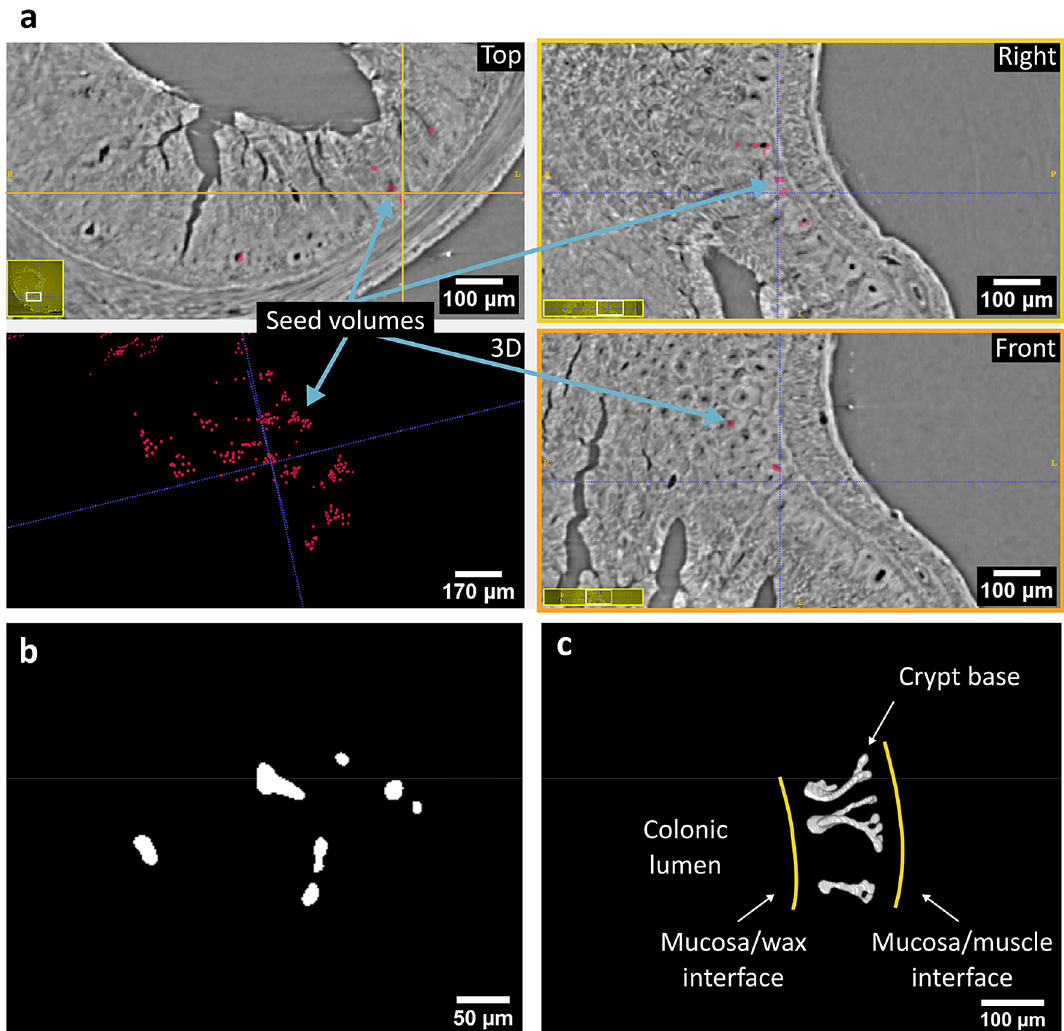
Figure 5. Budding crypt identification and 3D segmentation. ( a ) The viewport of ITK-SNAP is composed of four views (Top, Right, Front and 3D). The panels Top, Right and Front show orthogonal cross sections of the SR CT stack. The panels Right and Front show cross sections across the yellow and orange lines on the panel named Top, respectively. The panel named 3D shows the CT mask with the volumes of the back-mapped seed points (resulting from the inverse mapping between the 3D cyclorama and the CT data). The 3D seed volumes shown in the panel 3D, which are overlaid on the CT stack in the panels named Top, Right, and Front, are used to initialise the segmentation and expand it throughout the crypt lumens using region growing. The panels named Top, Right, and Front only show a zoomed-in view of the respective orthogonal cross sections. The white rectangles within the yellow panes on the bottom left corners of the Top, Right, and Front panels show which part of the cross sections is displayed in the panel. ( b ) Each slice of the image stack produced by the segmentation procedure is a binary image, with pixels corresponding to the crypt lumens having the value of one (white) and zero (black) elsewhere. ( c ) A 3D rendering of the binary image stack reveals the budding crypts and their position in space within the